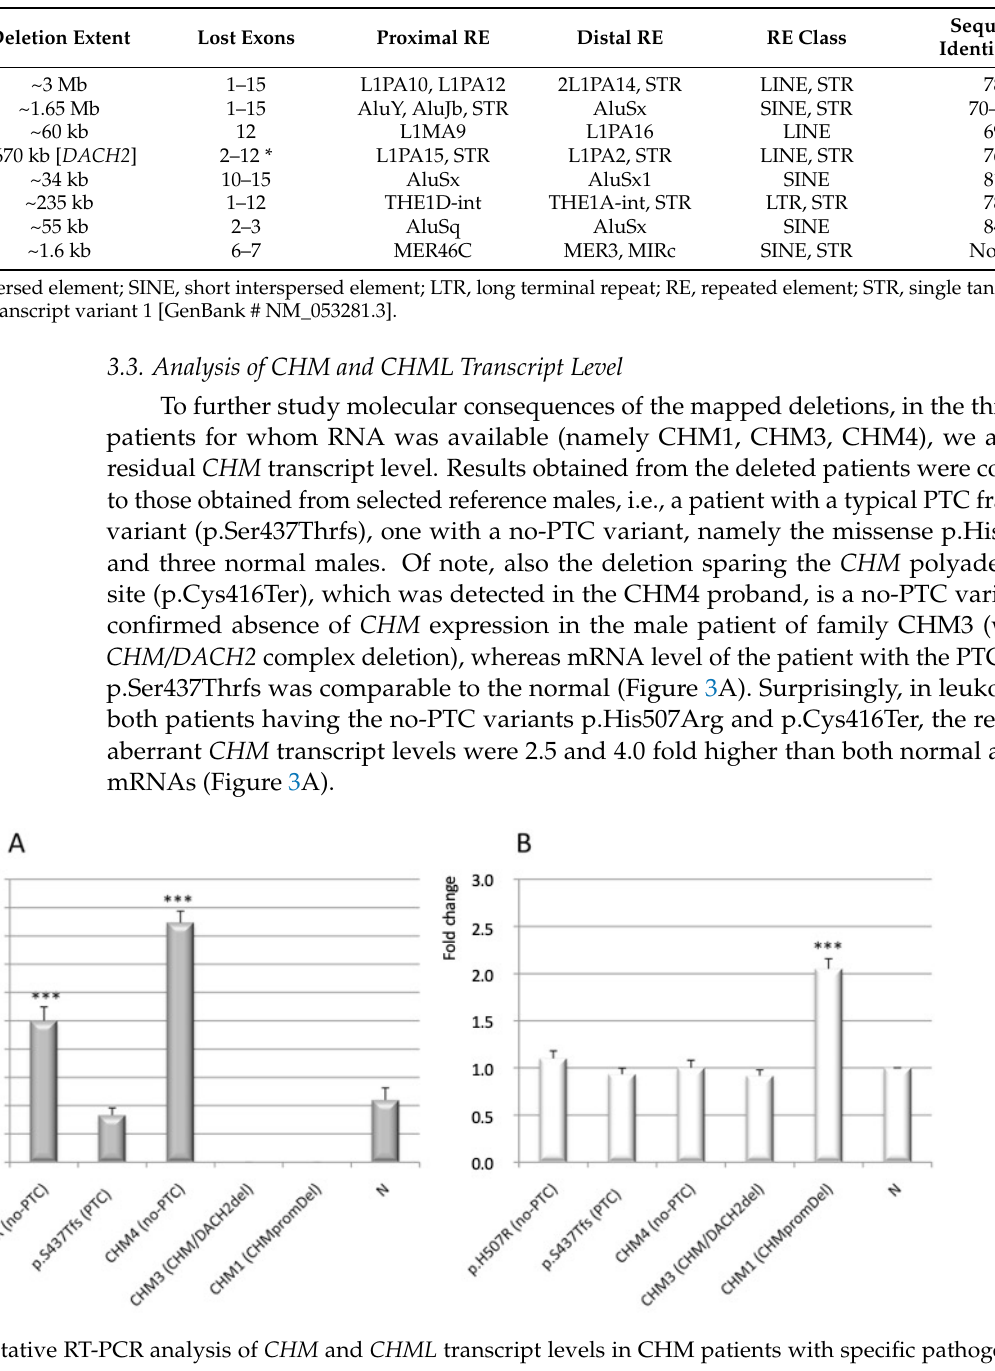
Table 2. High identity repeated elements surrounding the choroideremia-associated deletion breakpoint regions within the CHM locus.